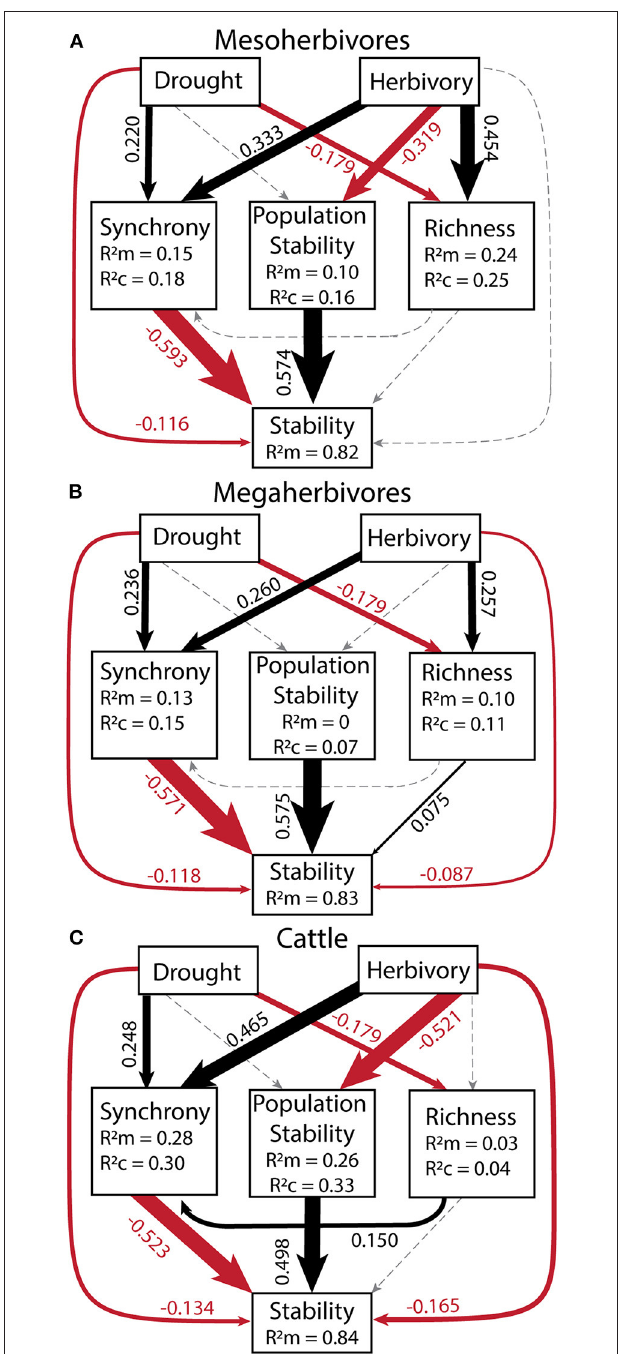
FIGURE 6 | Structural equation models for each herbivore group: mesoherbivores (A) , megaherbivores (B) , and cattle (C) to determine the relative strength of direct vs. indirect effects of drought and herbivory. All variables in the model were calculated over a 10-year moving window in order to compare to the corresponding drought score of each time window. Goodness of Fit values were: for mesoherbivores C = 4.00, p = 0.406, df = 4 (A) , for megaherbivores C = 8.86, p = 0.065, df = 4 (B) , and for cattle C = 13.79, p = 0.008, df = 4 (C) . Values next to arrows (direct effects) are scale standardized estimates of coefficients and arrow width is scaled to their (Continued)